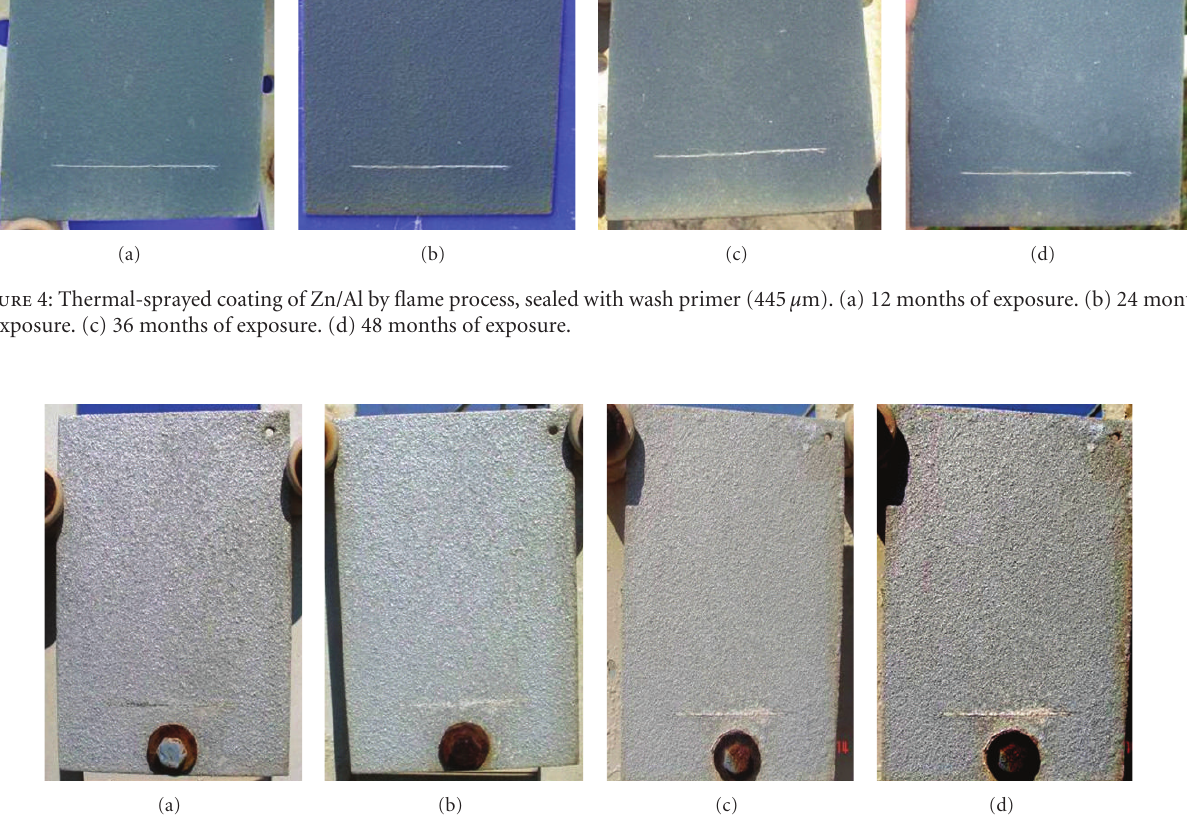
Figure 5: Thermal-sprayed coating of Zn/Al by flame process (318 μ m) (a) 12 months of exposure. (b) 24 months of exposure. (c) 36 months of exposure. (d) 41 months of exposure.